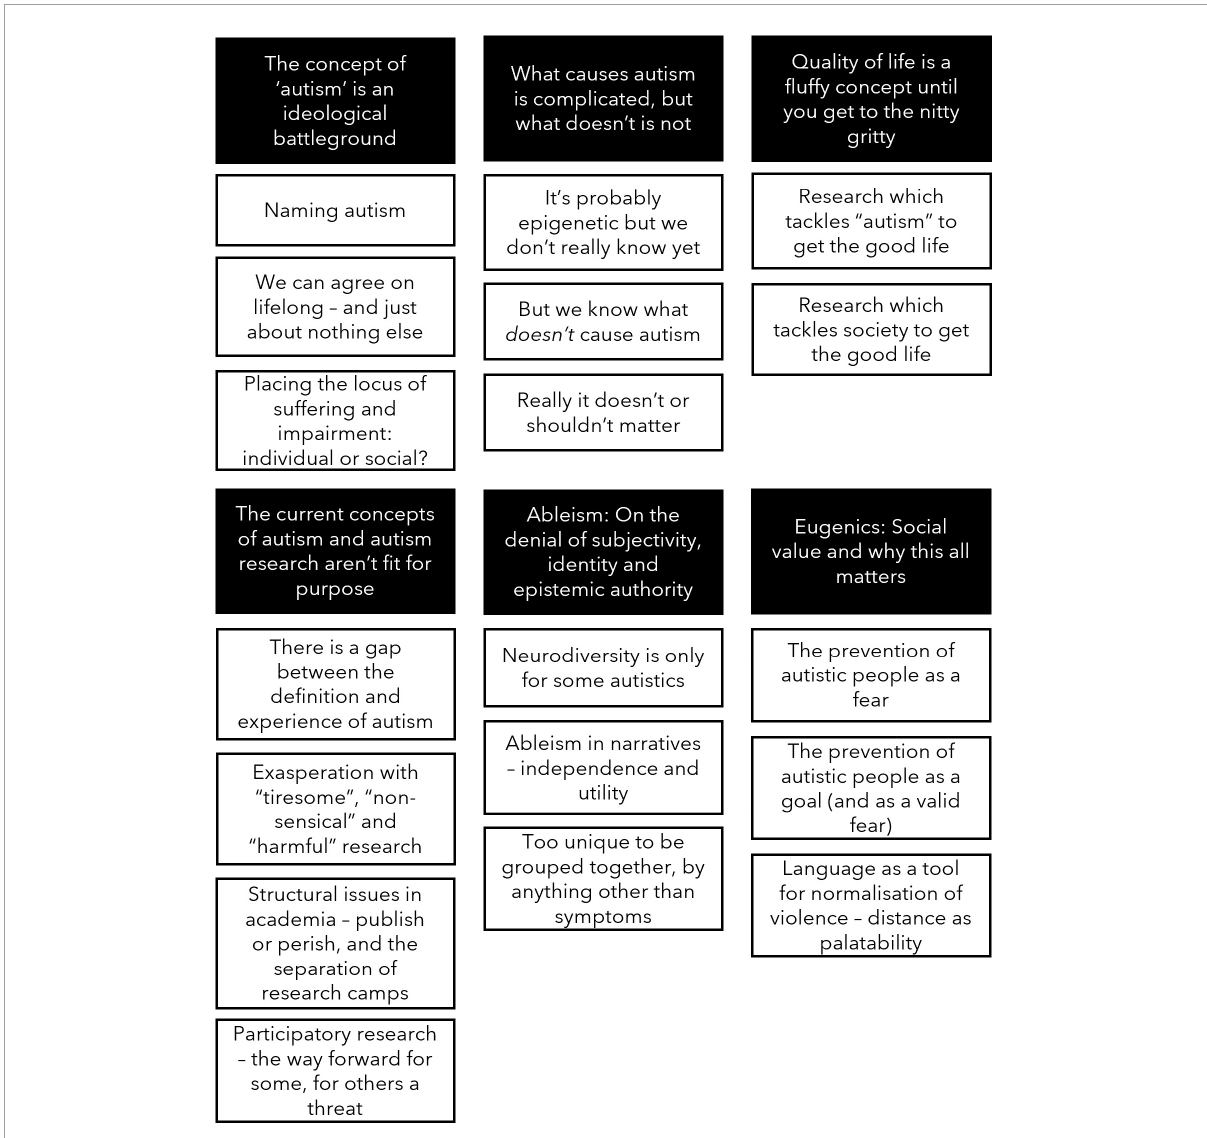
FIGURE1 Thematic map showing the themes and sub-themes